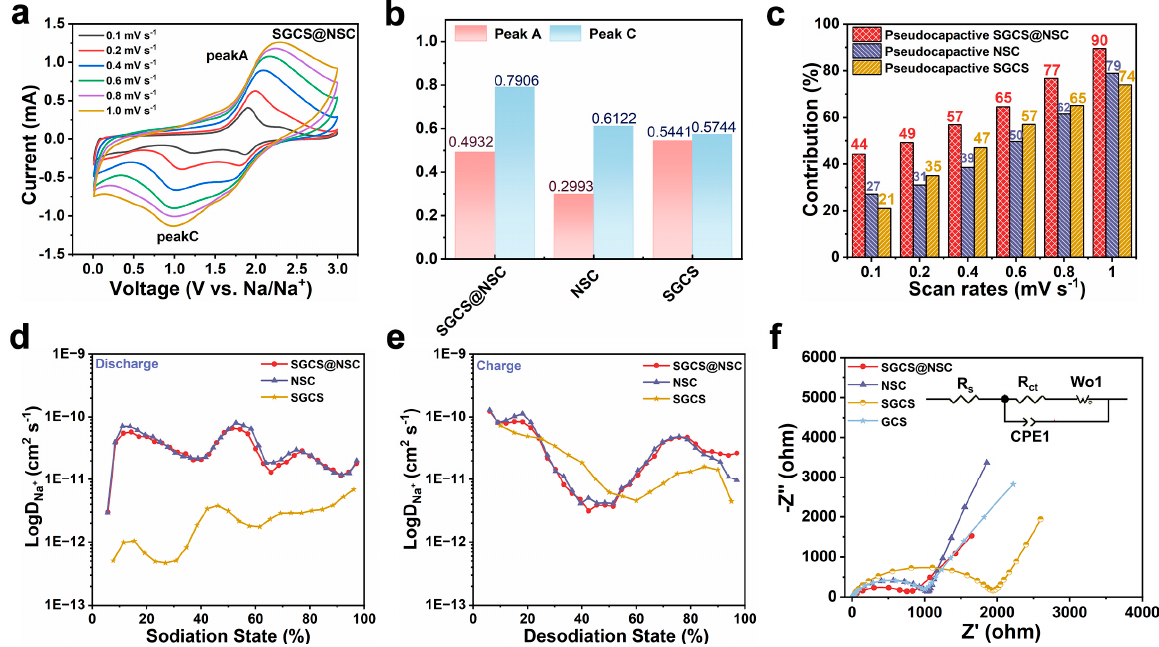
Figure 4. ( a ) CV curves of SGCS@NSC with scan rates from 0.1 to 1 mV s − 1 . ( b ) Log ( 𝑖 ) versus log ( 𝑣 ) plots of SGCS@NSC, NSC, and SGCS at peak A and C. ( c ) Normalized pseudocapacitive contribution ratios of SGCS@NSC, NSC, and GCS at different scan rates (0.1–1 mV s − 1 ). ( d , e ) The Na + diffusion coefficient of SGCS@NSC, SGCS, and NSC (discharge and charge) obtained by GITT tests. ( f ) EIS spectra of SGCS@NSC, NSC, SGCS, and GCS electrodes and equivalent circuit.